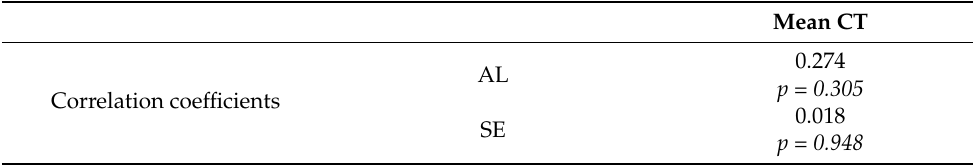
AL AL SE SE AL AL SE SE